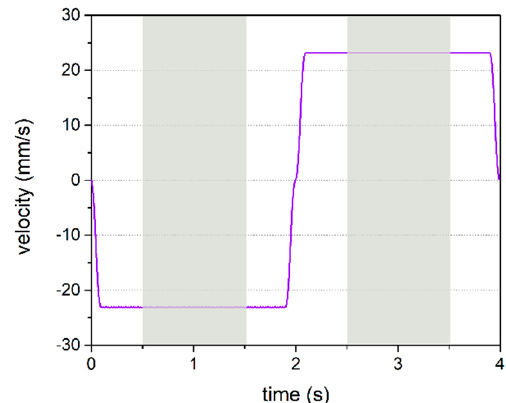
Figure 5. Velocity of the carriage versus time for one backward (negative velocity) and one forward (positive velocity) movement. The measured frictional, contact area and vibrational parameters are analyzed at time domains marked by the grey areas; i.e., at constant velocity.